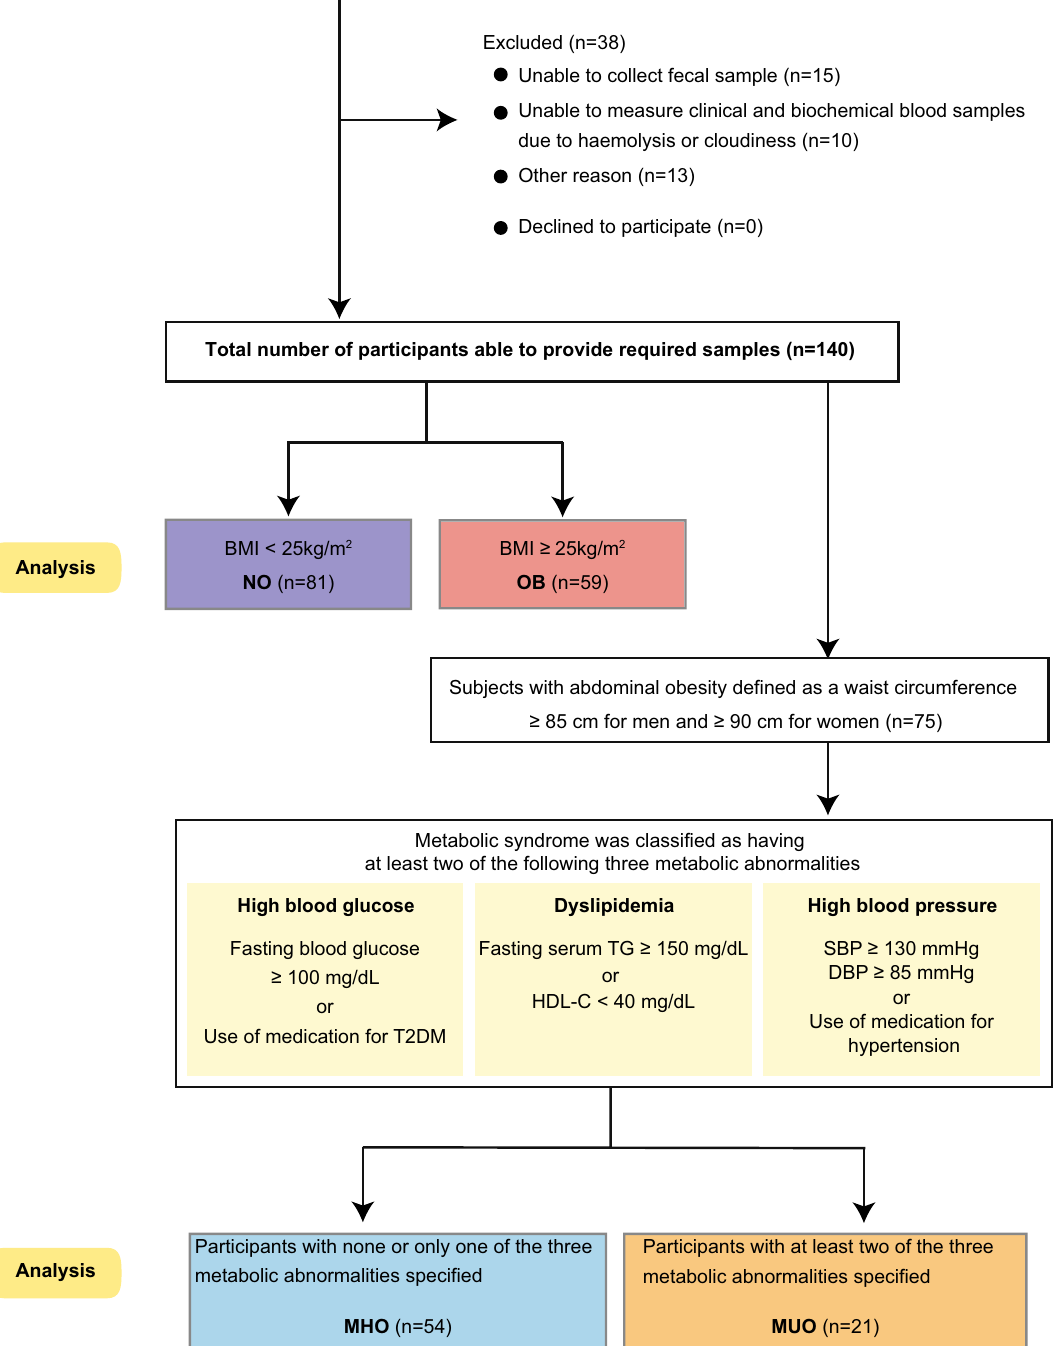
Figure 1. Study scheme. NO; non-obese (n = 81), OB; obese, (n = 59), MHO; metabolically healthy obese (n = 54) and MUO; metabolically unhealthy obese (n = 21). Graphics were made using the Adobe Illustrator (version: